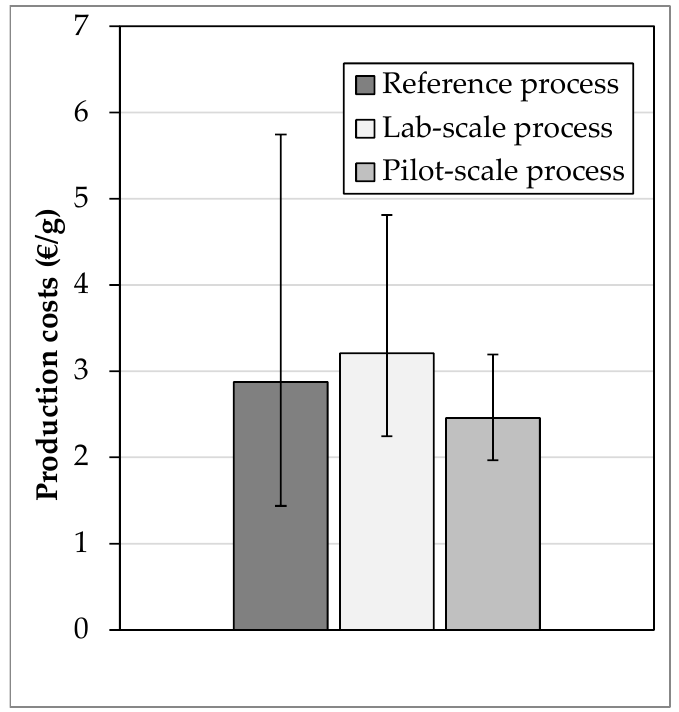
Figure 7. Summary of the specific production costs.